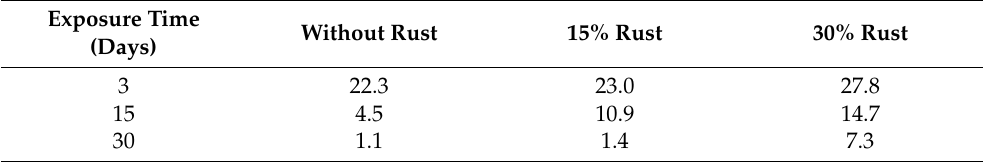
Table 3. Misclassification rate (R m ) for different percentage of